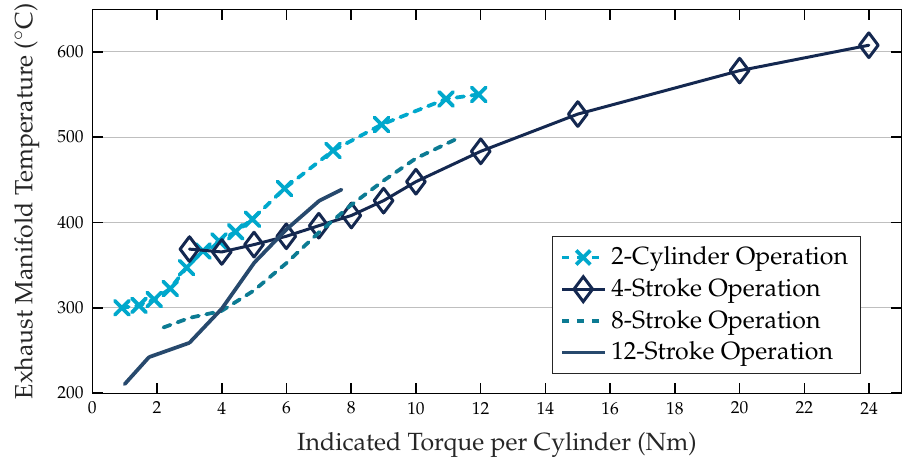
Figure 9. Measured exhaust manifold temperature during load variations in 4-, 8-, 12-stroke four- cylinder operations and a four-stroke two-cylinder